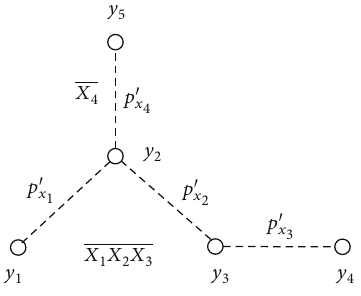
Figure 6: Illustration of an MVI term and an SVI one with a common node.